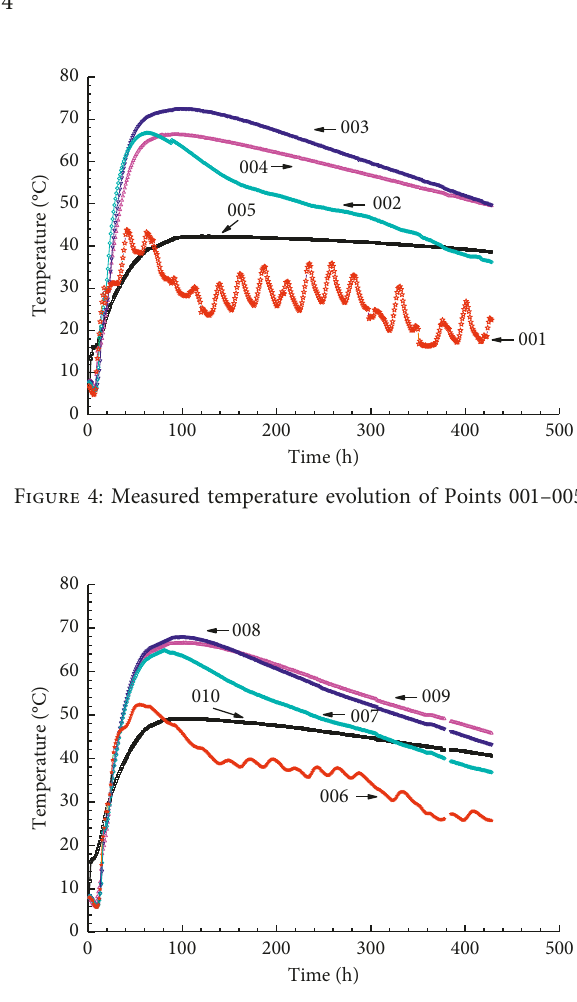
Figure 7: Temperature variation along the vertical direction of the